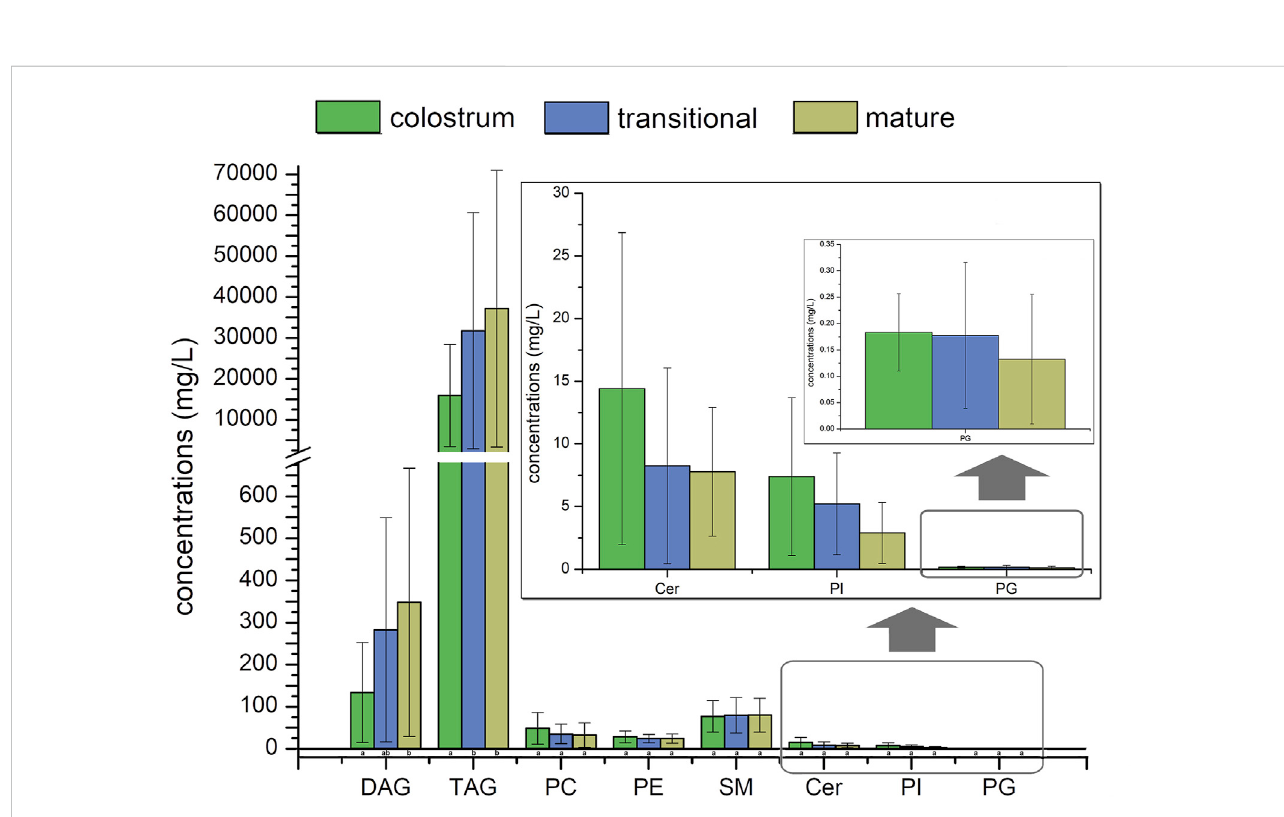
FIGURE 3 Concentrations of human milk lipids at different lactation